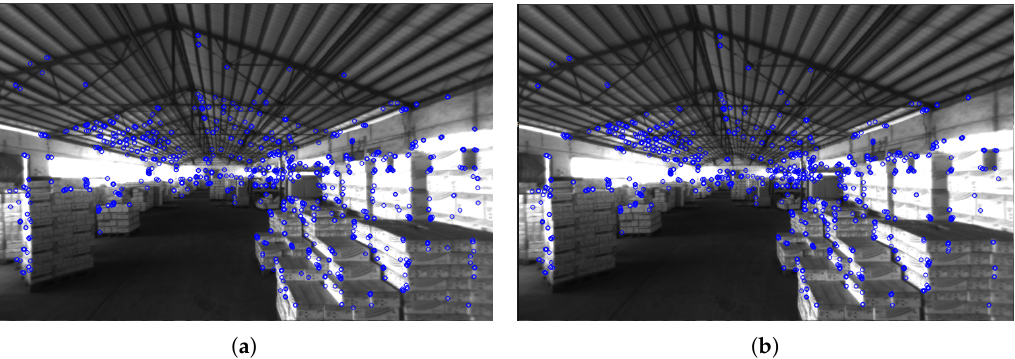
Figure 8. Feature extraction results of the same image by two feature extraction algorithms. ( a ) The proposed two step dynamic threshold feature extraction. ( b ) The method that divides the image into m × n cells and extracts features in each